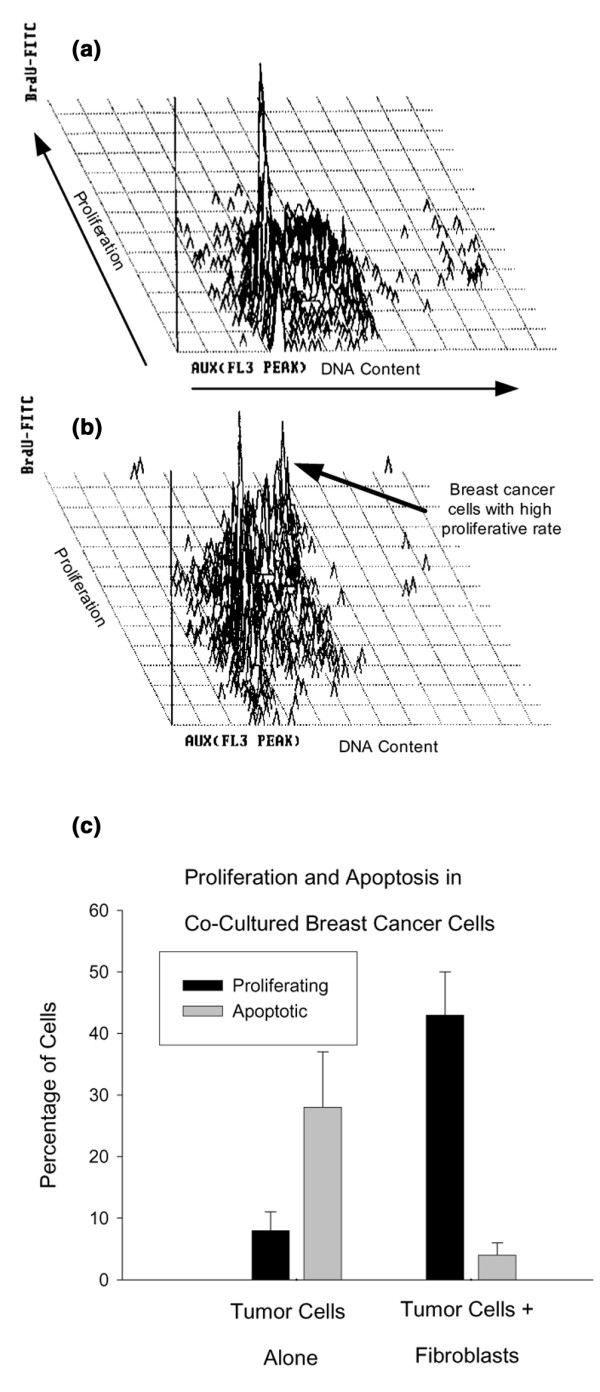
Results of flow cytometric measurements of proliferation and apoptosis. There was a distinct peak of (b) breast cancer cells with a high proliferative rate compared with (a) breast cancer cells cultured without fibroblasts. (c) Tumor cells grown on fibroblasts had a significantly higher proliferative rate and a lower apoptotic rate than did tumor cells cultured alone.